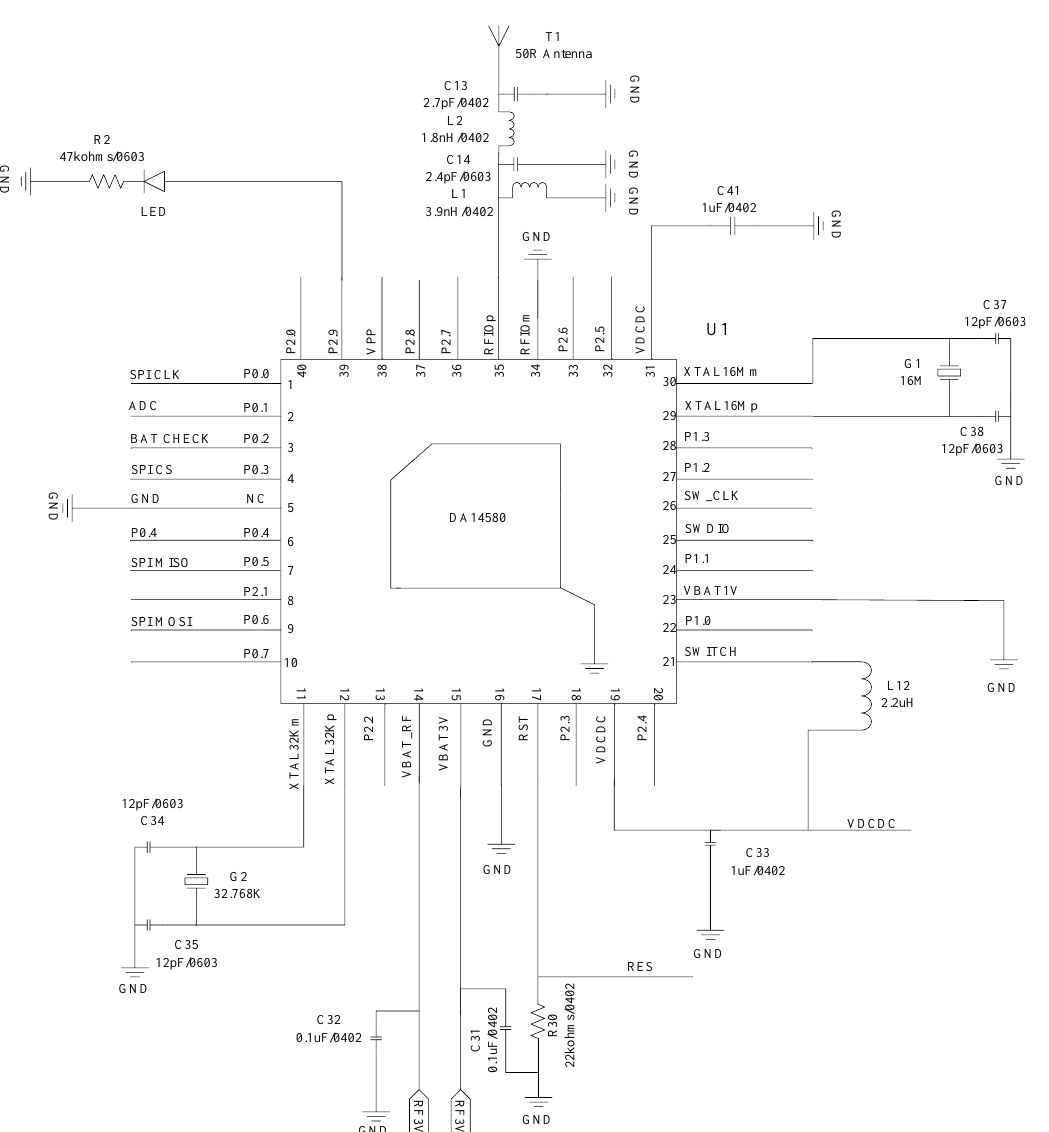
Figure 7. Peripheral circuit of the MCU chip. The DA14580 chip has a built-in 32 KB One-Time-Programmable (OTP) memory, which can be programmed once only, using an extra flash chip W25X20CL [30]. As shown in Figure 8, the W25X20CL serial flash memory can not only provide an extra storage solution, but also a solution with more flexibility and better performance than using an ordinary serial flash device. An SPI protocol is used for the data communication with the chips. Figure 8. External flash circuit.